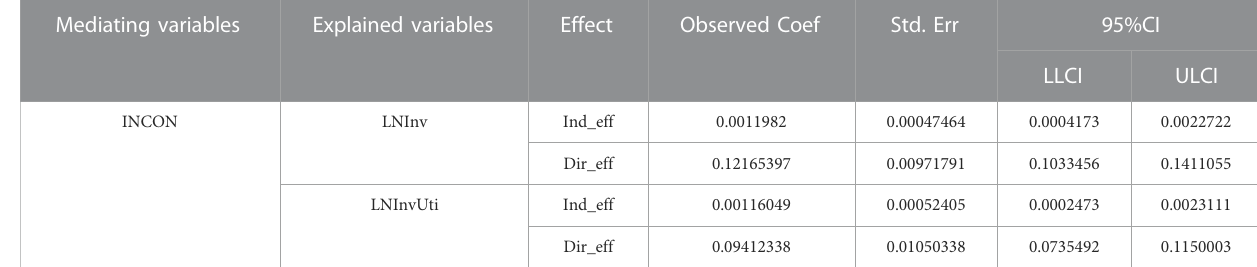
TABLE 5 Mediation effect of internal control. Mediating variables Explained variables